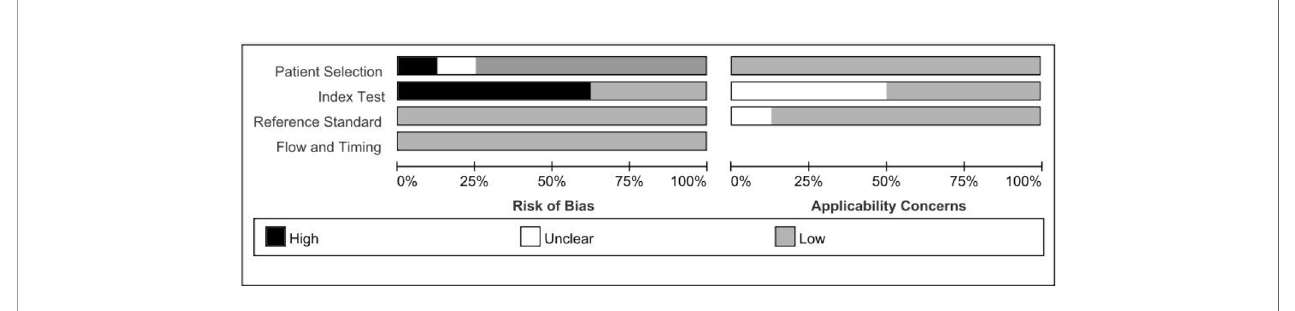
FIGURE 3 | The graphical of QUADAS-2 results.